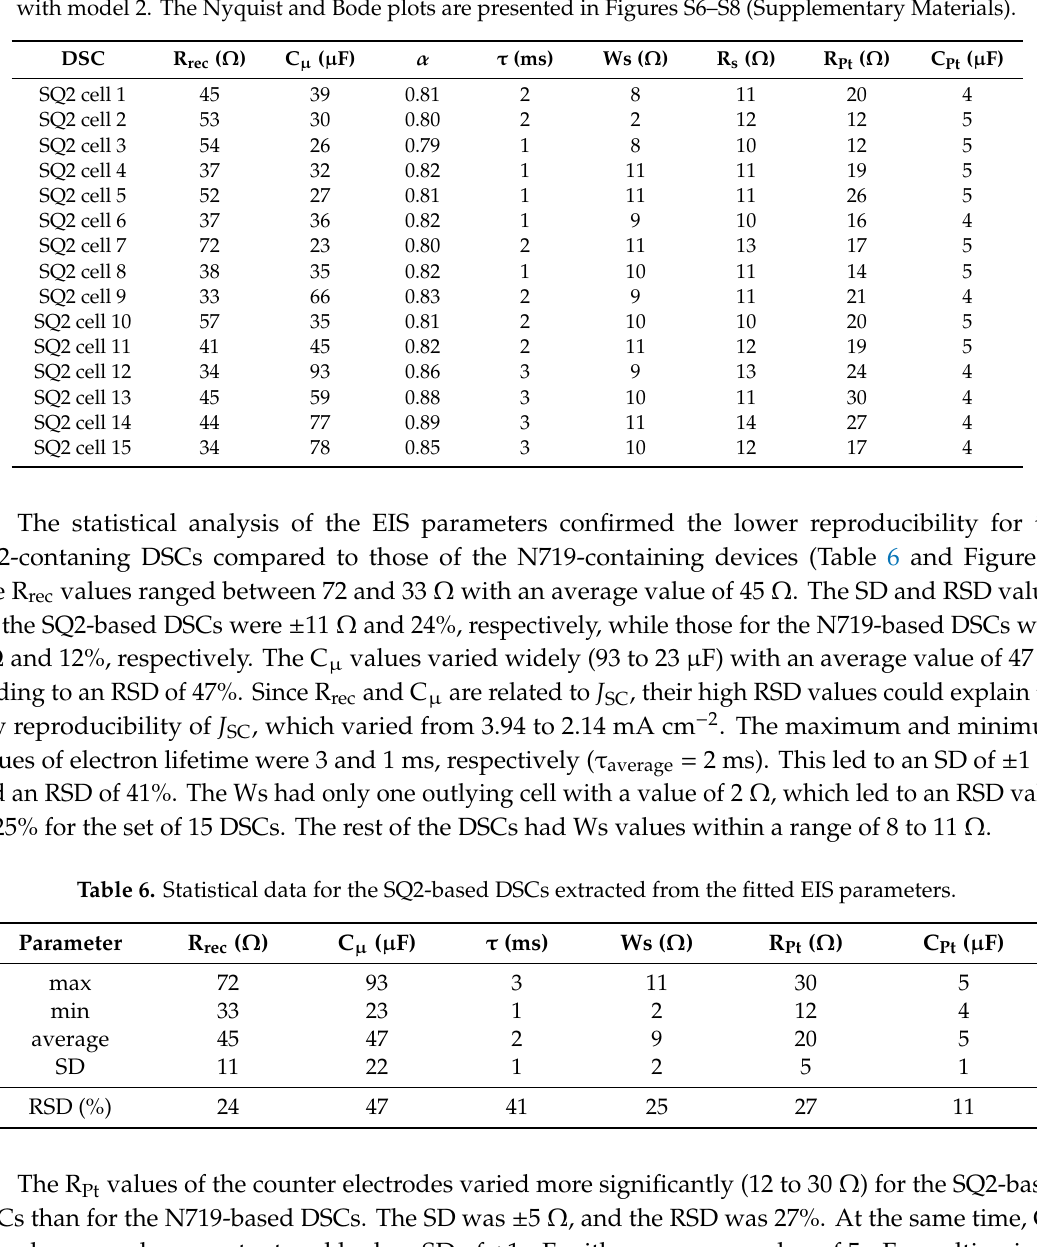
Table 5. The EIS parameters for the DSCs with SQ2 dye in an API range (45–60 min), which were fitted with model 2. The Nyquist and Bode plots are presented in Figures S6–S8 (Supplementary Materials).